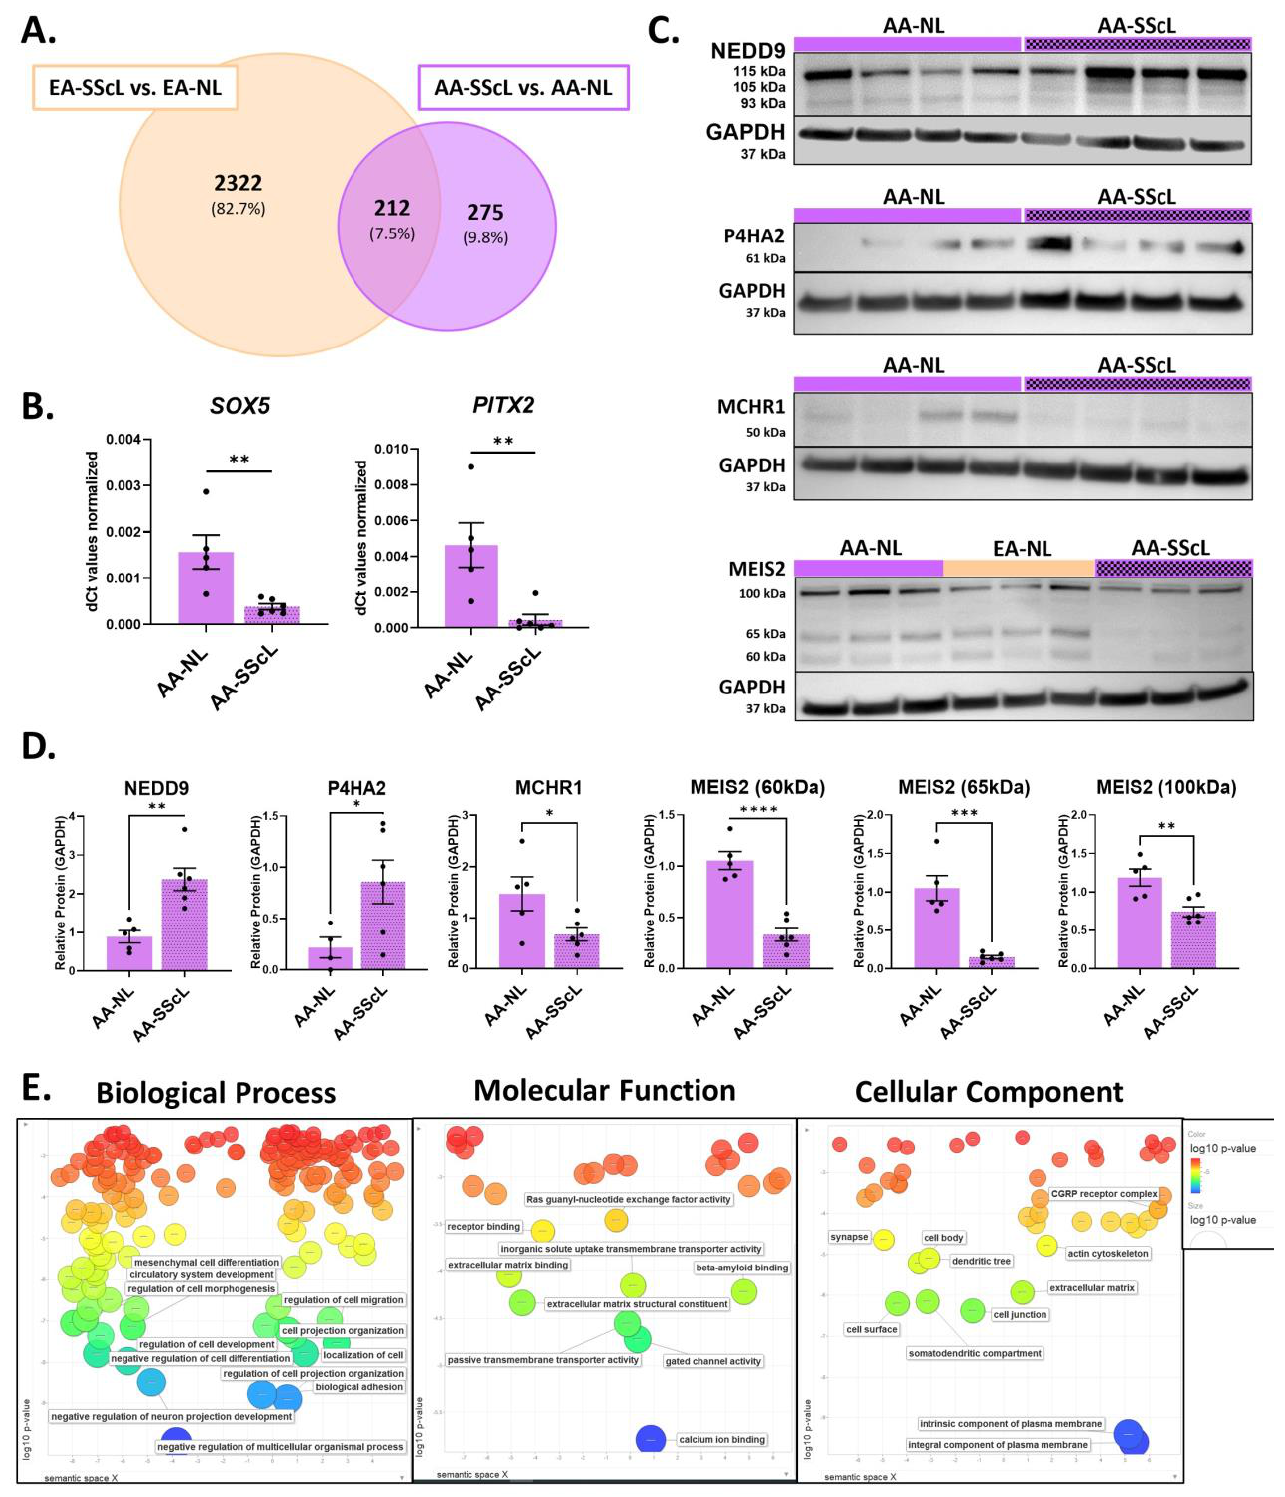
Figure 3. Defining unique disease mechanisms in AA-SScL fibroblasts. ( A ) Venn diagram for the DEGs from the comparisons “SScL vs. NL” in the fibroblasts of SSc-PF AA and EA patients. At the intersect, 212 DEGs are commonly deregulated in both races, while 2322 DEGs are unique to EA-SScL fibroblasts, and 275 DEGs are unique to AA-SScL fibroblasts. ( B ) Expression levels of SOX5 and PITX2 in AA-NL and AA-SScL fibroblasts. ( C ) Representative Western blots for NEDD9 (three bands), P4HA2, MCHR1, and MEIS2 (three bands). ( D ) Quantification of protein abundance of NEDD9 (three bands quantified together), P4HA2, MCHR1, and MEIS2 (three bands quantified sep- arately) in the lysates of AA-SScL fibroblasts compared to AA-NL fibroblasts normalized to GAPDH loading control. ( E ) GO terms obtained from ToppFun for the 275 DEGs unique to AA-SScL fibro- blasts were entered in REViGO. The scatter bubble plots for Biological Process, Molecular Function, and Cellular Component terms are shown here. Terms in blue and at the bottom of the scatterplot are more enriched than those in red. Only the most enriched terms are labeled in the scatterplot. The